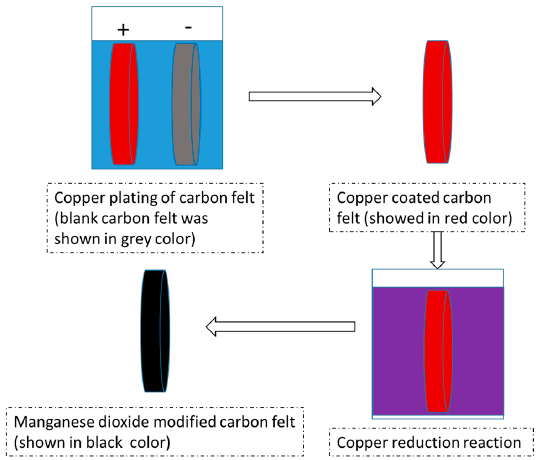
Figure 2. The procedure of manganese dioxide modification of blank carbon felt (arrows indicated the order of operations).